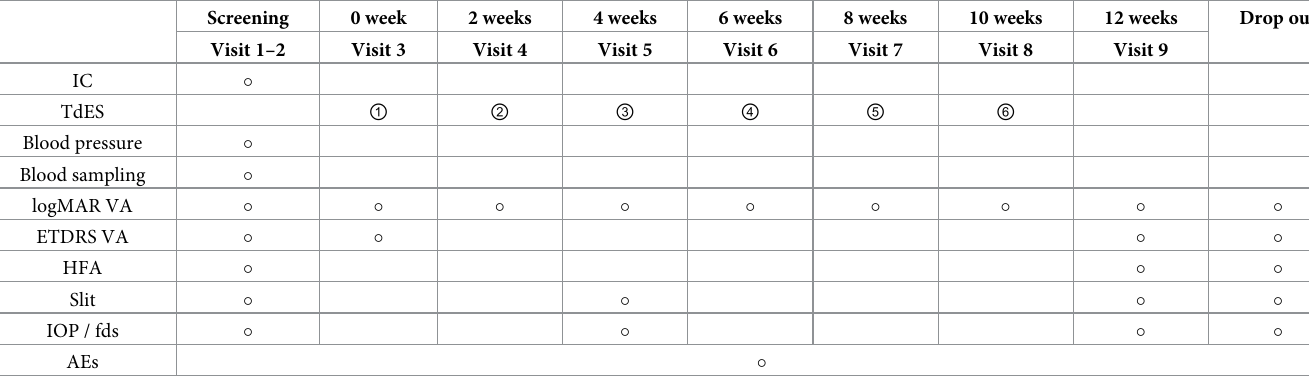
Abbreviations: IC, informed consent; TdES, transdermal electrical stimulation; VA, visual acuity; HFA, Humphrey field analyzer; Slit, slit lamp examination;